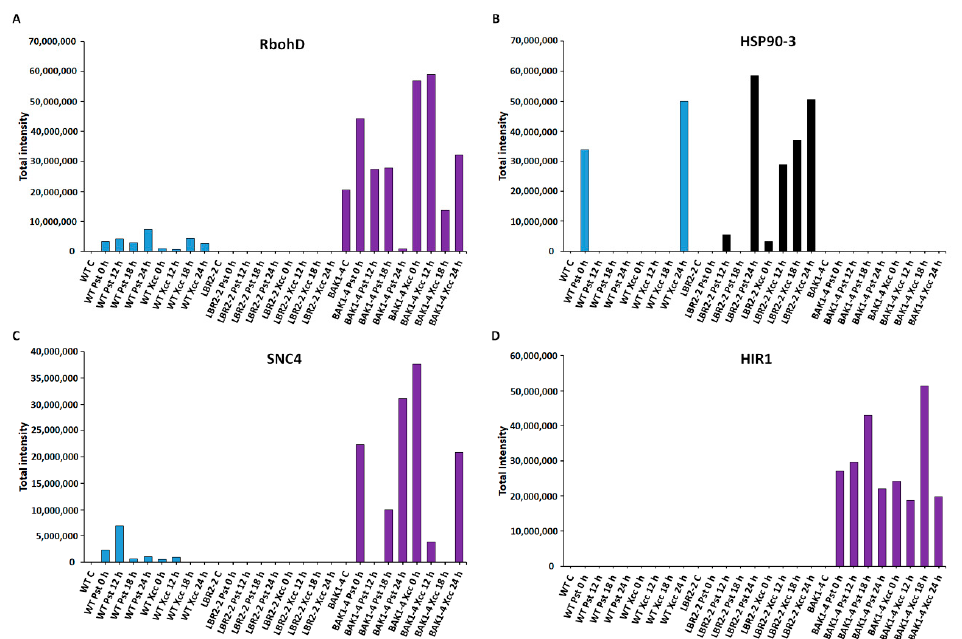
11 of 30 Figure 5. Comparative analyses of total peak intensities of PM-associated proteins involved in stress and defence responses . Total peak intensity of selected significant PM-associated proteins for ( A ) Respiratory burst oxidase homolog protein D (RbohD), ( B ) Heat shock protein 90-3 (HSP90-3), ( C ) Protein SUPPRESSOR OF NPR1-1 CONSTITUTIVE 4 (SNC4) and ( D ) Hypersensitive-induced response protein 1 (HIR1). Data from the WT are indicated in blue, the lbr2-2 mutant in black and the bak1-4 mutant in purple, with time periods of 0–24 h as indicated.